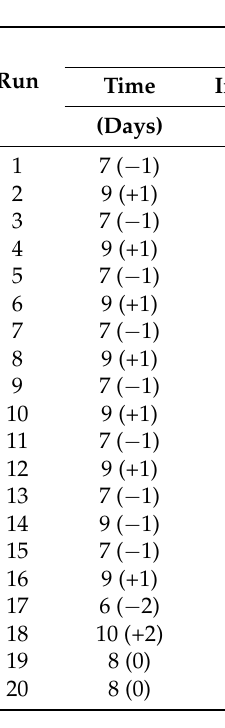
Table 2. Experimental conditions and results of the statistical experimental design for the production of laccases by P. sanguineus